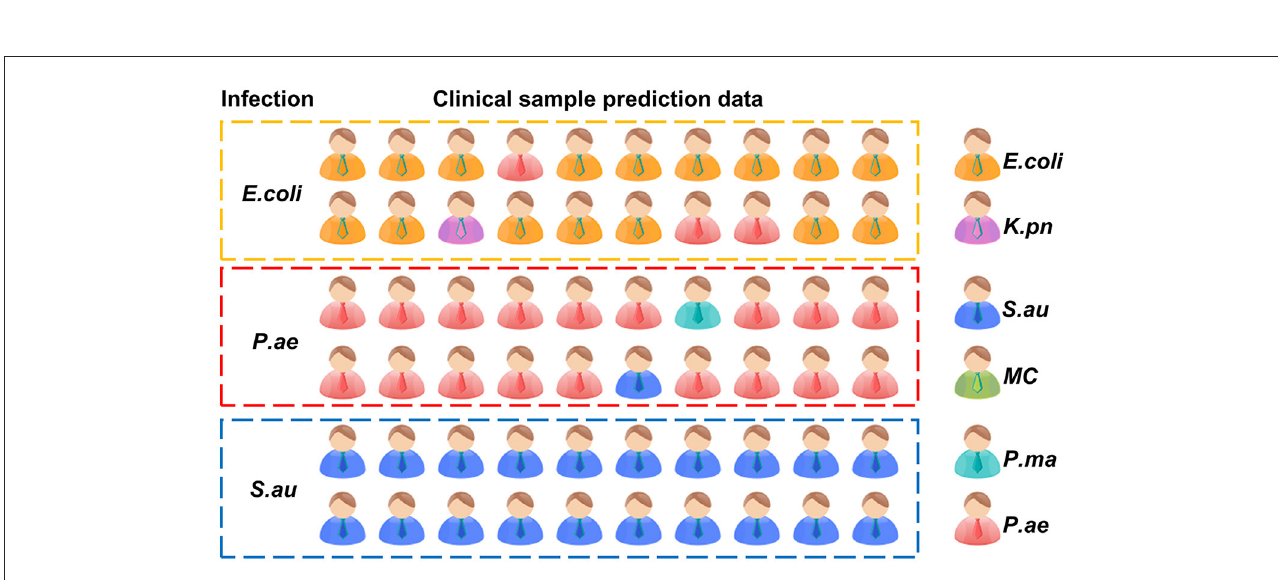
FIGURE8 XGB model established to predict the pathogen in clinical